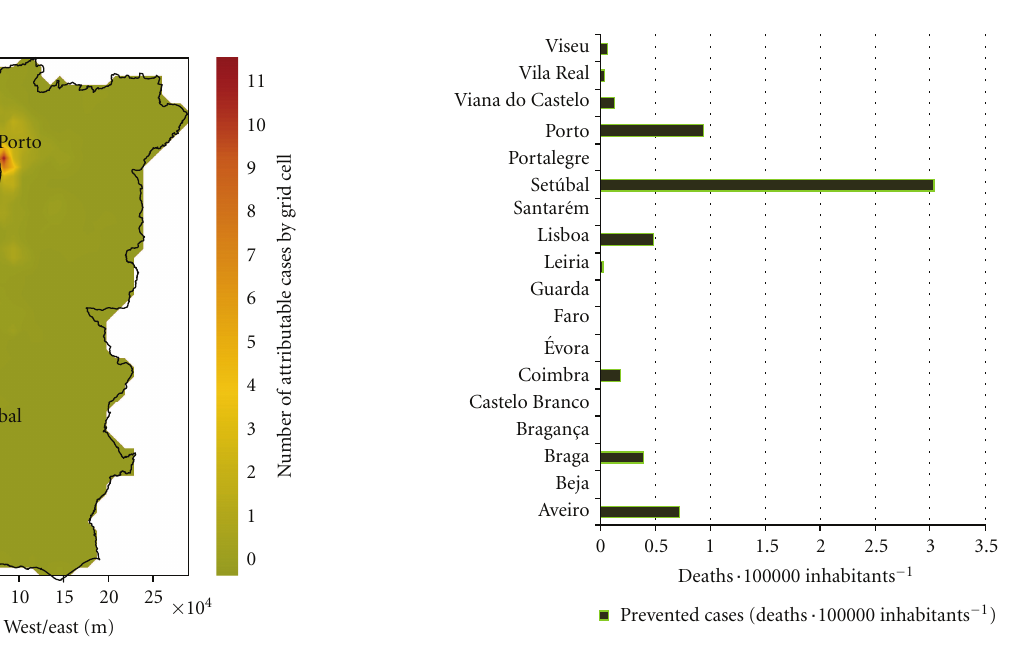
Figure 10: Spatial distribution of the increased number of attribu- table cases estimated by grid cell (10 × 10km 2 ) related to short-term PM10 exposure for future climate.